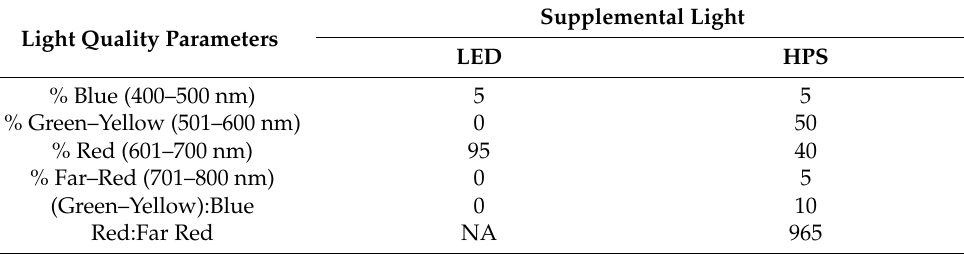
Table 5. Spectral characteristics of LED and HPS fixtures. For blue, green and red, spectral com- position (%) was calculated relative to the PPF range (400–800 nm) and rounded to an accuracy of